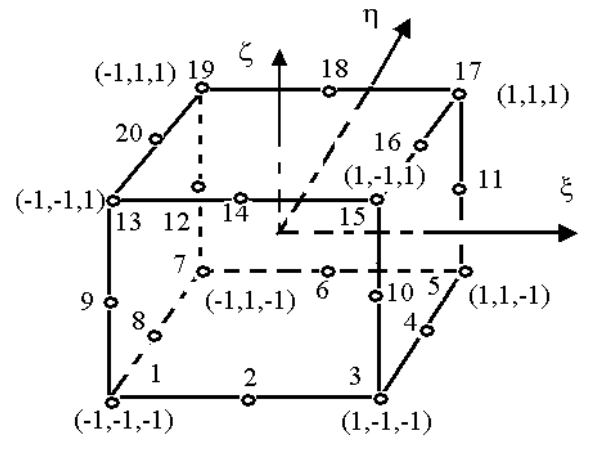
FIG. 1. Mesh example of the KEKB-LER vacuum chamber, used by the space charge solver for the photoelectron cloud. FIG. 2. 20-node brick